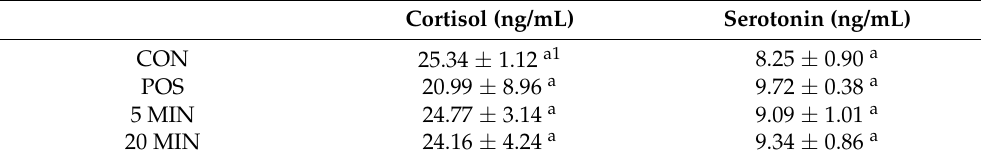
Table 6. Changes in stress hormones in